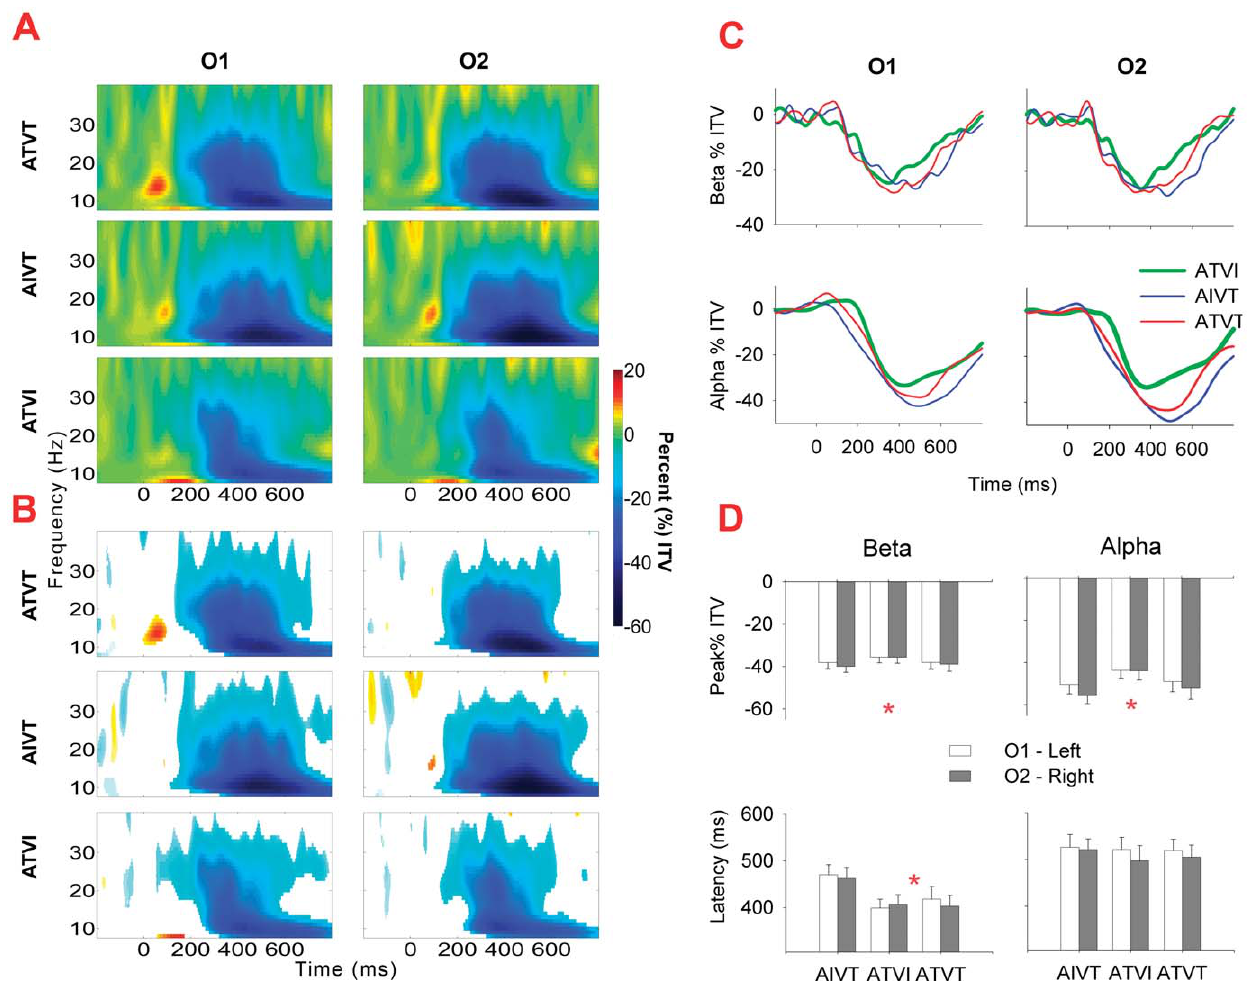
Figure 5. Inter-trial variance for audiovisual stimuli at occipital electrode sites. A . For occipital electrodes O1 and O2, percentage (%) of increase and decrease in inter-trial variance (ITV) in the 8–40 Hz frequency range for ATVI (auditory target and visual irrelevant), AIVT (auditory irrelevant and visual target) and ATVT (audiovisual dual target) stimuli. B . For each stimulus type at O1 and O2, non-significant ( p . .01 determined using a bootstrap procedure) changes in inter-trial variability (ITV) from the baseline are occluded using a white mask. C . Mean alpha (8–13 Hz) and beta (14–30 Hz) ITV across time for electrodes O1 and O2. D . Mean amplitude and latency of peak minima ( + SEMs ) in the alpha and beta frequency range for O1 and O2 electrodes, (* p , .05 for main effect of stimulus type for two-way